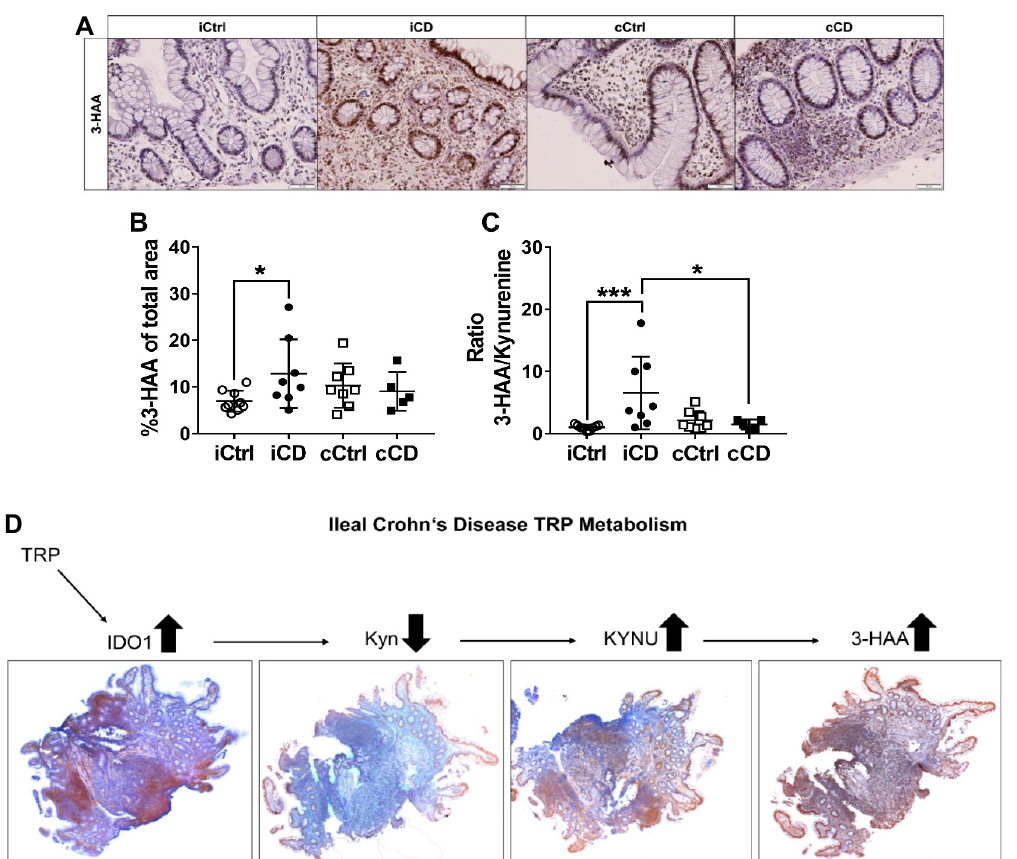
Figure 5. Increased 3-HAA levels in ileal CD. ( A ) Analysis of the 3-HAA metabolite distribution pattern in paraffin-embedded tissue of patients with CD via IHC (representative images, magnification 20×). Inflamed tissue of patients with ileal and colonic CD were compared with noninflamed control samples. Active inflammation was determined by the Riley score. ( B ) Differential quantitative and localization-dependent evaluation of total 3-HAA+ area in CD compared to non-IBD control. The 3-HAA/kynurenine ratio was calculated in tissue of ( C ) CD compared to non-IBD control. ( D ) Summary of the TRP enzyme and downstream metabolite expression pattern in iCD (magnification 4×). ( B , C ) Data are shown as mean ± SD of n = 4–9 for different patients and controls; * for p ≤ 0.05, and *** for p < 0.001, using the Mann–Whitney test. cCD = colonic CD, cCtrl = colon non-IBD control, iCD = ileal CD, iCtrl = ileum non-IBD control.